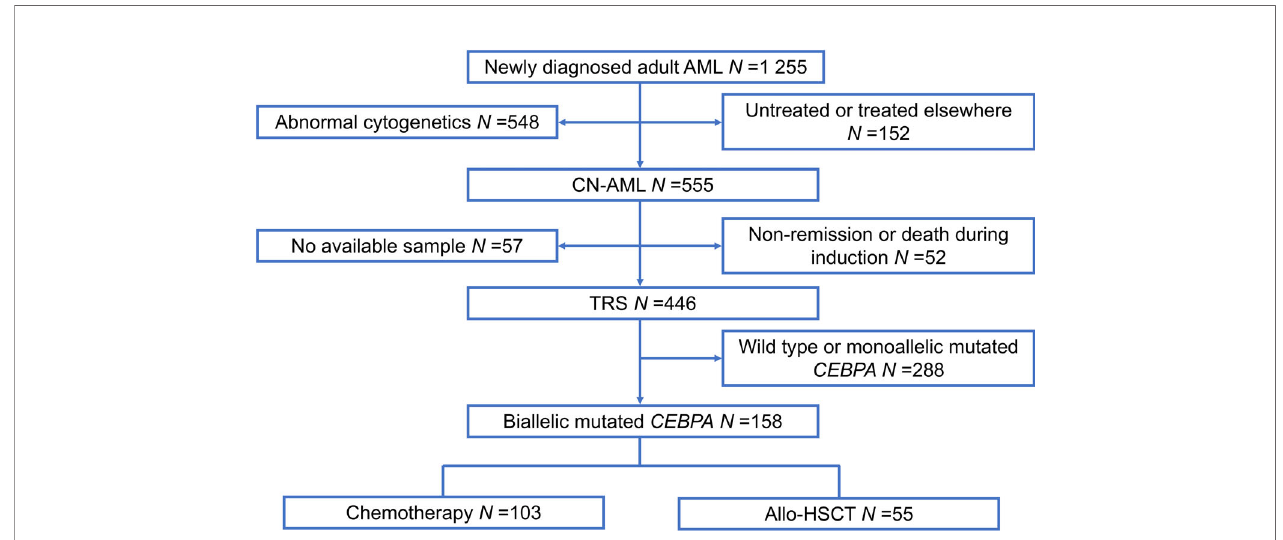
FIGURE 1 | Patient recruitment and cohort assignment. AML, acute myeloid leukemia; CN, cytogenetically normal; TRS, targeted region sequencing; Allo-HSCT, allogenic hematopoietic stem cell